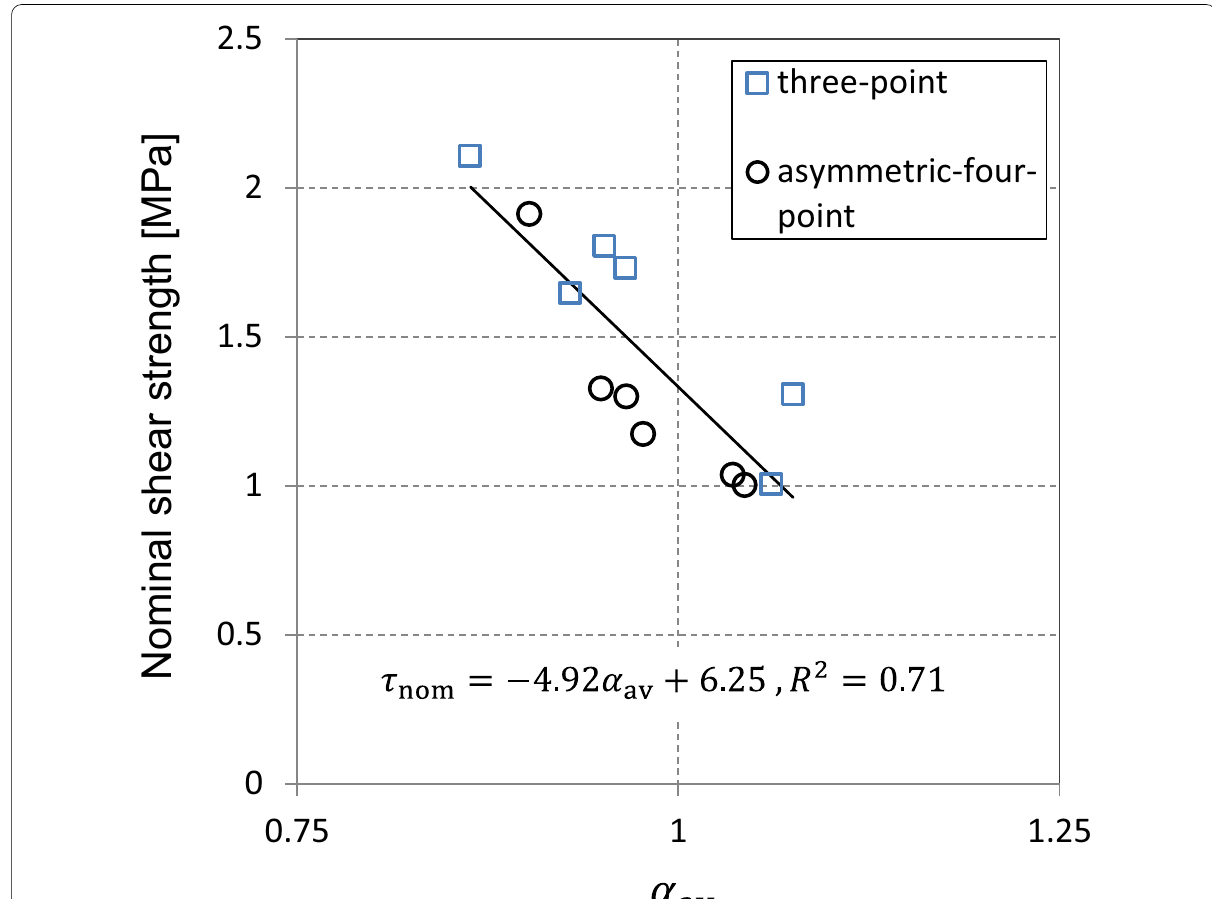
Fig. 13 Relation between nominal shear strength and the magnitude of shear stress in the cross layer ( α av